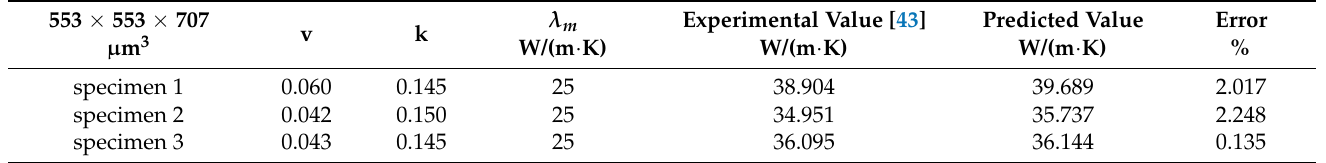
Figure 8. Three-dimensional morphology of graphite in ( a ) specimen 1, ( b ) specimen 2 and ( c ) specimen 3. Table 3. The comparison of experimental value and predicted value of own data.